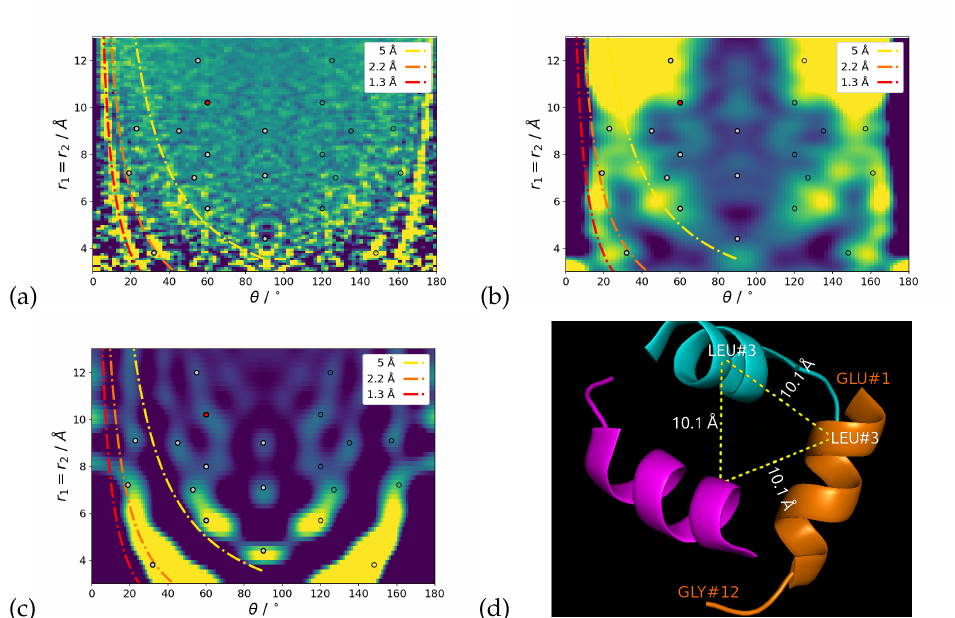
Figure 7. Comparison between PADFs of a single-helix protein (1AL1) generated via different methods. ( a ) PADF generated from atomic model, no intensity scaling. ( b ) PADF generated from atomic model, enhancing peaks between 40 ◦ and 90 ◦ . ( c ) PADF generated from q -space correlation, showing corresponding peak positions. ( d ) Atomic models of three symmetric 1AL1 proteins in the crystal, showing one of the possible contributions on the peak intensity at approximately 60 ◦ , 10